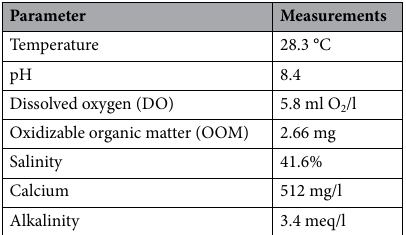
Table 1. The hydro-chemical and physical properties of collected sea water samples.